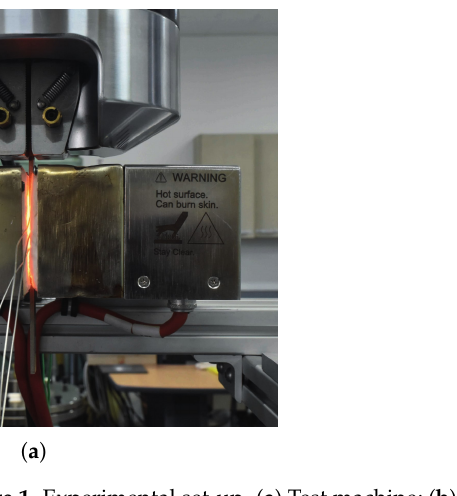
Figure 1. Experimental set-up. ( a ) Test machine; ( b ) Specimen with